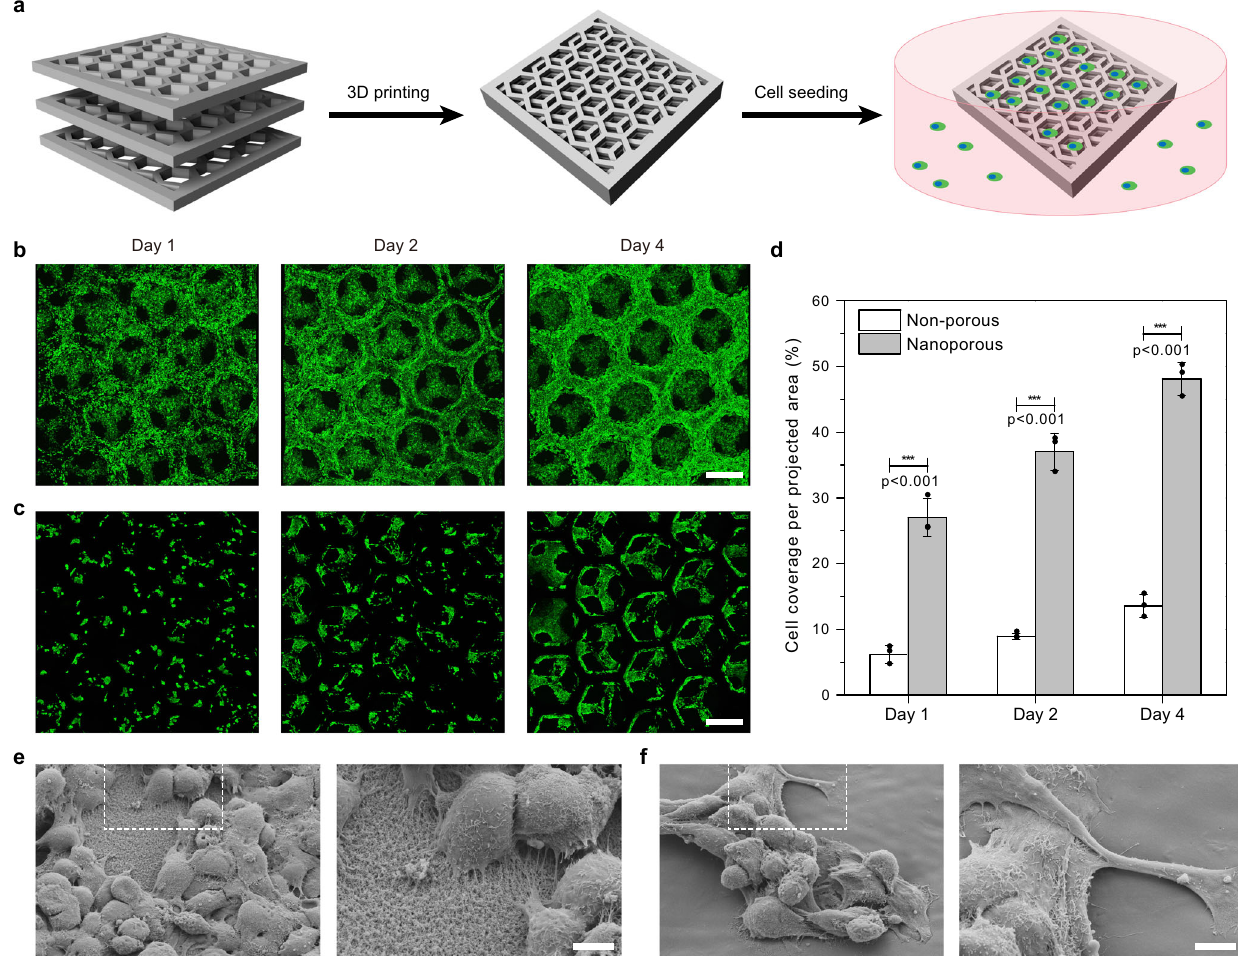
Fig. 5 Hierarchical inherently nanoporous scaffolds with improved biocompatibility for 3D cell culture. a Schematic representation of the scaffolds´ geometry. b , c 3D confocal microscopy images of Hep G2 cells cultured on the inherently nanoporous scaffold ( b ) and the non-porous scaffold ( c ) after 1, 2, and 4 days of culture (day 1, day 2 and day 4 from left to right). Scale bars: 500 μ m. The 3D confocal images were integrated from 30 z-stack images with a single stack thickness of 10 µ m. d Coverage of live cells (Calcein-positive) per projected area per projected area calculated from the 3D confocal images within a volume of 3 × 3 × 0.3 mm 3 . Error bars are standard deviations of three independent experiments ( N = 3). The statistical signi fi cance was assessed using unpaired two-tailed Student ’ s t test. e , f Overview and zoom-in SEM micrographs of Hep G2 cells cultured on the inherently nanoporous scaffold ( e ) and the non-porous scaffold ( f ) after 1 day. Scale bars: 5 μ m. The SEM images shown are representative of three replicates ( n = 3) over three independent experiment ( N =